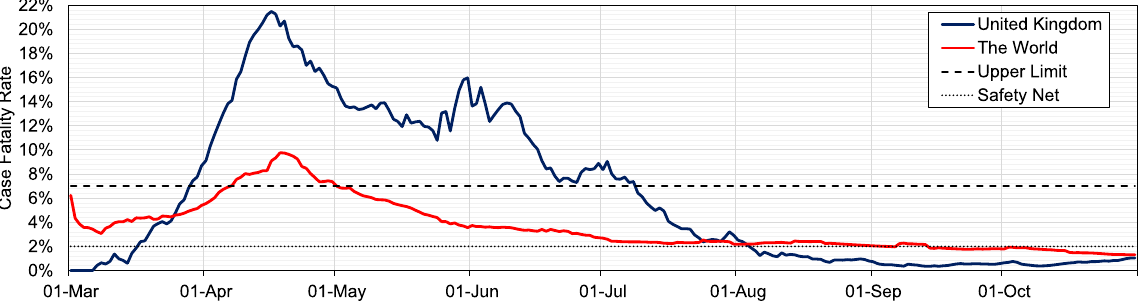
Fig. 8. Case fatality rate (CFR) in the United Kingdom and the world calculated using equation